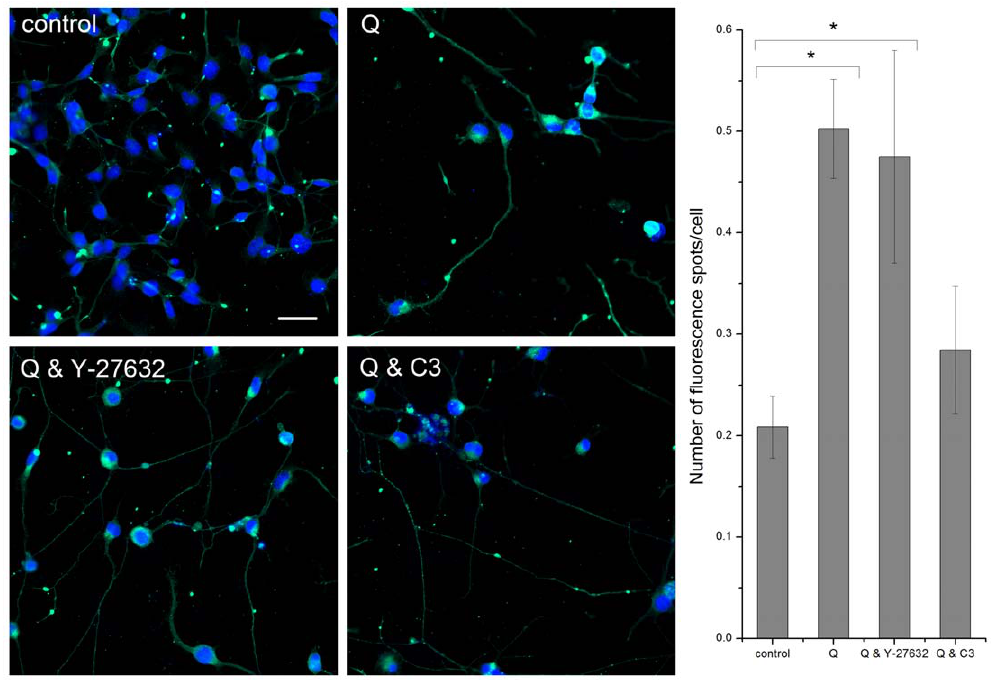
Figure 2. Isoquercitrin and localization of synaptotagmin-1. Left , The immuno-staining images show that synaptotagmin-1 localizes especially at spots along the neurites induced by isoquercitrin (Q) alone or combined with Rho inhibitors (Y-27632, C3 transferase). Green=synaptotagmin-1, blue=nuclei. Scale bar=50 micron. Right , The bar graph shows the quantification of the fluorescence spots along the neurites (n=10 images, one-way ANOVA, * p , 0.05). Data are shown as means 6